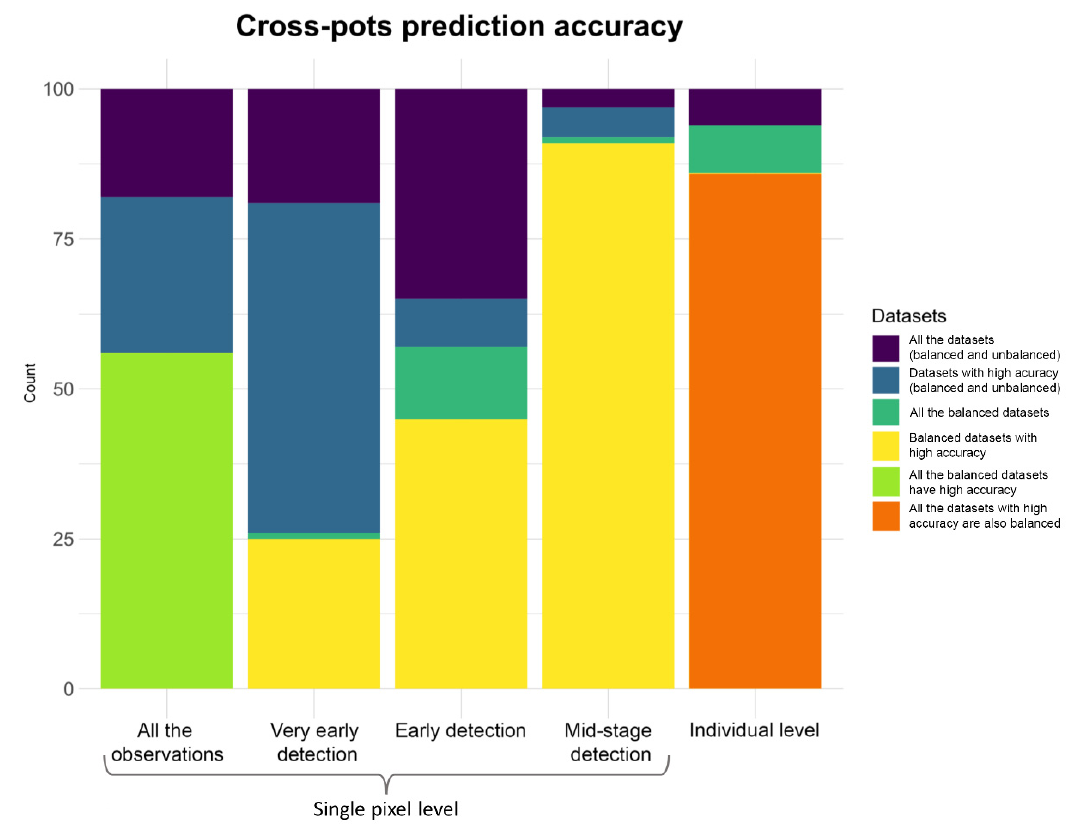
Figure 10. Bar plot showing the frequency of overall and partial accuracy statistics for the 100 resampled testing datasets. Each bar represents the total of the 100 predictions on testing pots (the height from 0 of the violet bar). From the left, the first 4 bars show the prediction results at the pixel level, while the last bar shows the same results but at the plant level. The height from 0 of the blue bars indicates the part of the predictions that have a high accuracy (>0.7). The height of the yellow bars indicates the number of only predictions made on datasets that showed the correction for class imbalance and gave accuracy values greater than 0.7. The height of the light green and orange bars are for special cases: The light green bar indicates that all datasets that were corrected for class imbalance showed high accuracy, while the orange bar indicates that all datasets that showed high accuracy was also corrected for class imbalance.